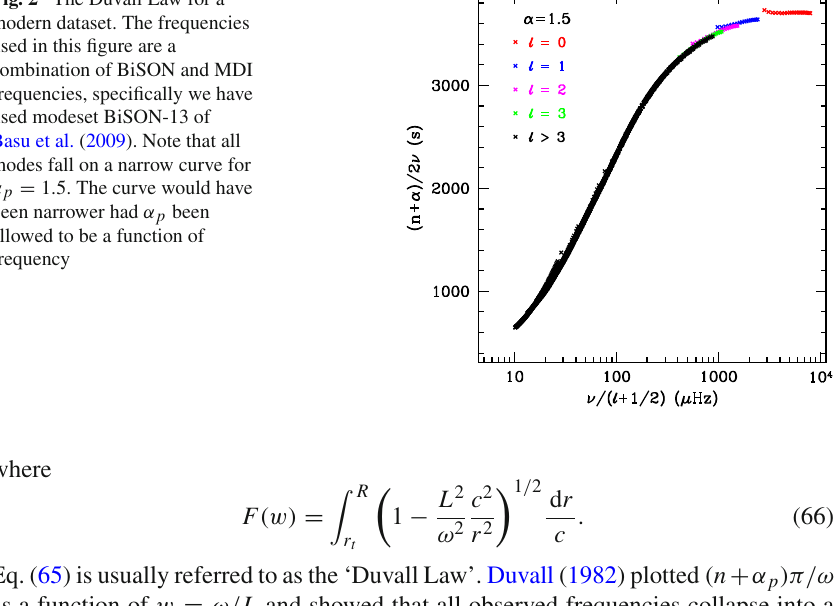
Fig. 2 The Duvall Law for a modern dataset. The frequencies used in this figure are a combination of BiSON and MDI frequencies, specifically we have used modeset BiSON-13 of Basu et al. (2009). Note that all modes fall on a narrow curve for α p = 1 . 5. The curve would have been narrower had α p been allowed to be a function of